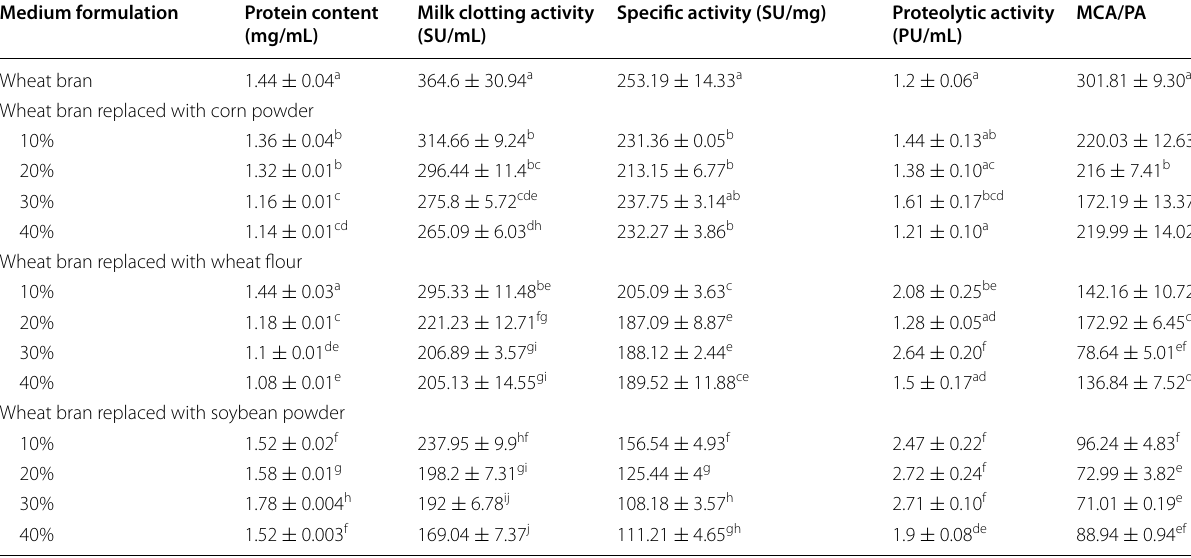
The results are expressed as mean SD. Within columns, values followed by the same letter(s) are not significantly different at the 0.01 level ± Table 4 The effect of nitrogen source on protease production by Rhizomucor miehei Type and concentration of nitrogen